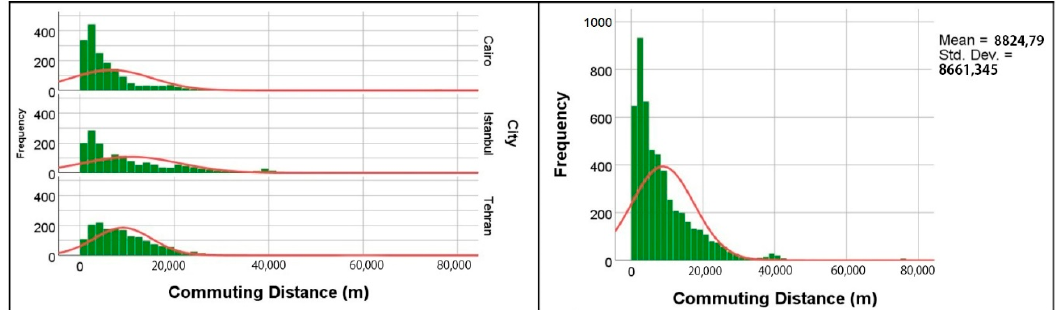
Figure 5. Distribution of commuting distances based on city (left) and the overall sample (right). Table 6. WLS model estimates for Tehran, Istanbul, and